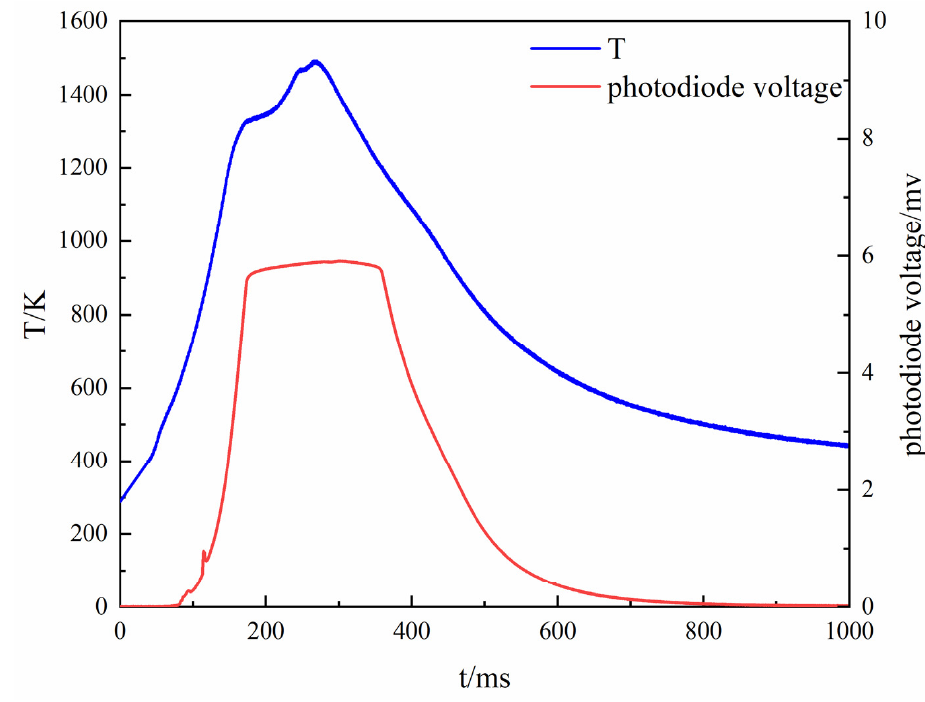
Figure 5. Curves of MgB 2 ignition temperature test.